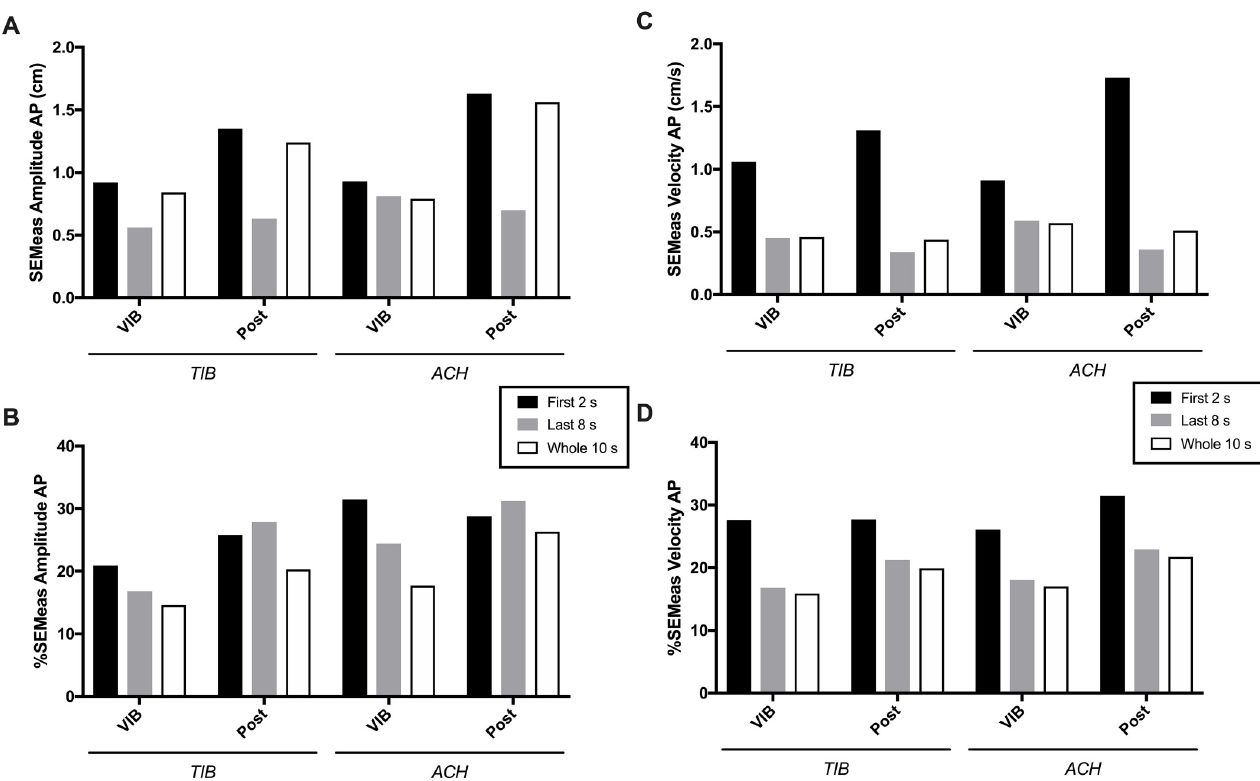
Fig 3. Intra-individual variability of Amplitude (A & B) and Velocity (C & D) center of pressure variables for the three time-windows analyzed. Variability is estimated by the standard error of the measurement expressed in the related unit of the measure (SEMeas) and in percentage of the pooled mean (%SEMeas) for. AP = anteroposterior axis; VIB & POST = vibration and post-vibration periods; TIB & ACH = tibialis anterior & Achilles’